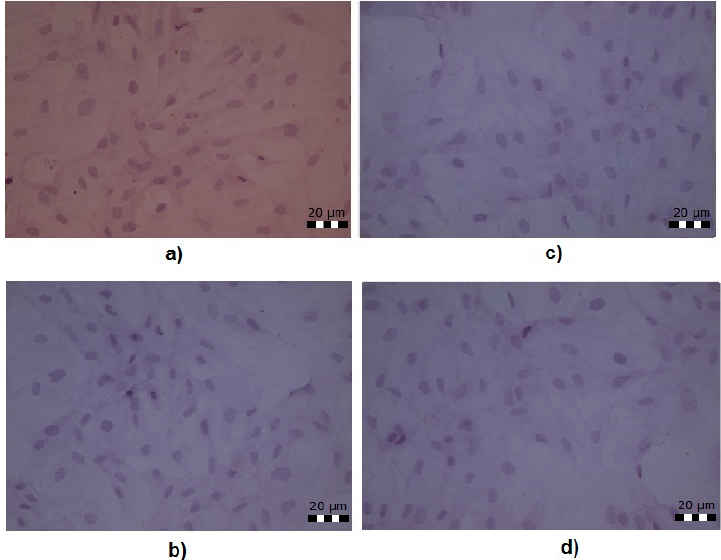
Figure 9. Cytotoxic tests of fibroblastic cells. ( a ) Ti–13Nb–13Zr alloy; ( b ) EO1 sample; ( c ) EO2 sample; ( d ) EO1 + EO2 sample. ( d ) EO1 + EO2